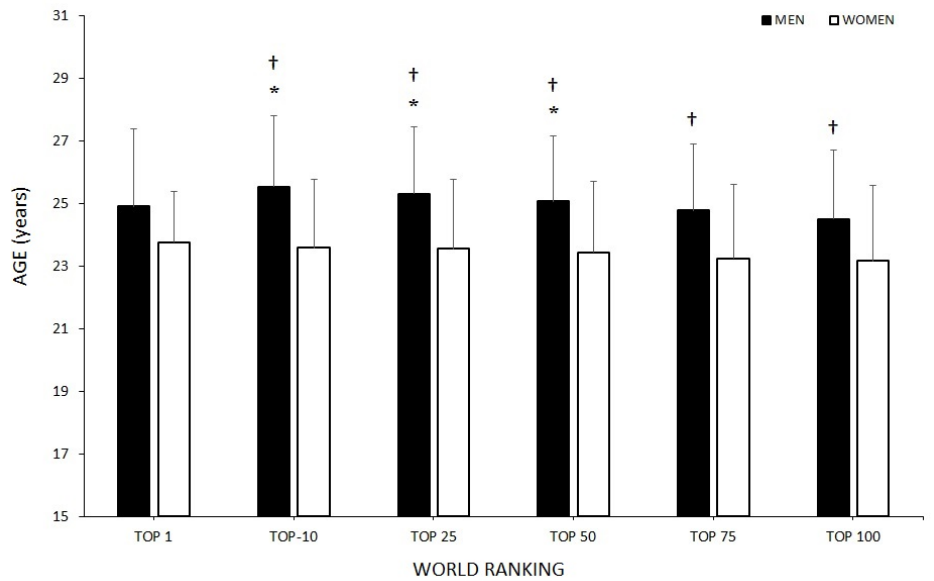
Figure 2. Average age of badminton players in reaching their peak performance considering their best career ranking in the World Ranking. * Significant differences in regard to the top 100 ( p < 0.05); † significant differences in regard to women players ( p < 0.05).